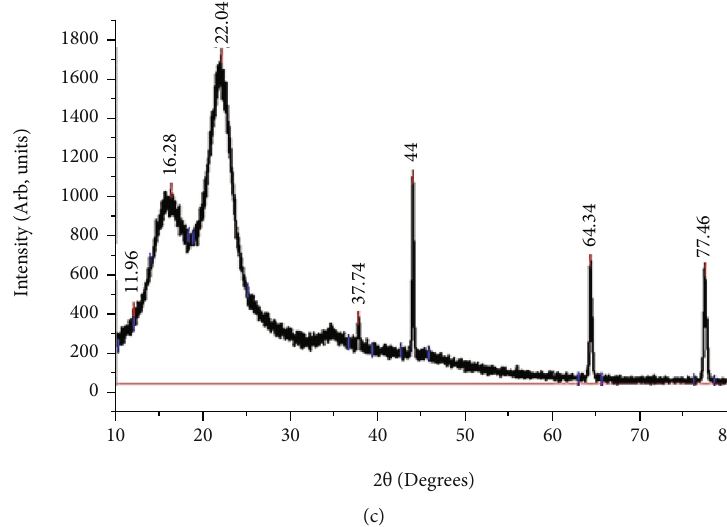
Figure 5: XRD patterns of untreated and treated Te ff straw: (a) UTS, (b) ATB, and (c) BTB. Table 1: Independent variables ’ range and level: (a) the BBD of the experimental matrix with experimental and predicted values for ATB and BTB